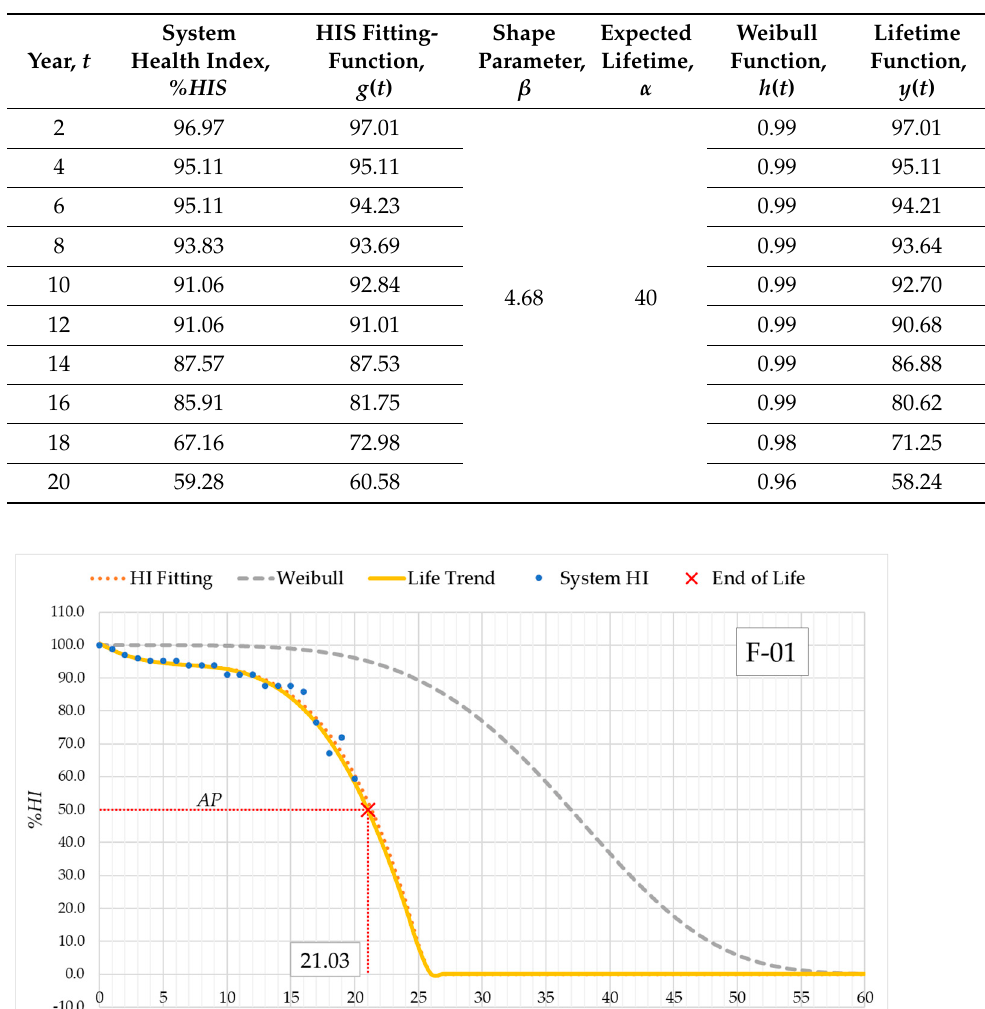
Table 6. Calculated parameters for lifetime estimation of feeder F-01.